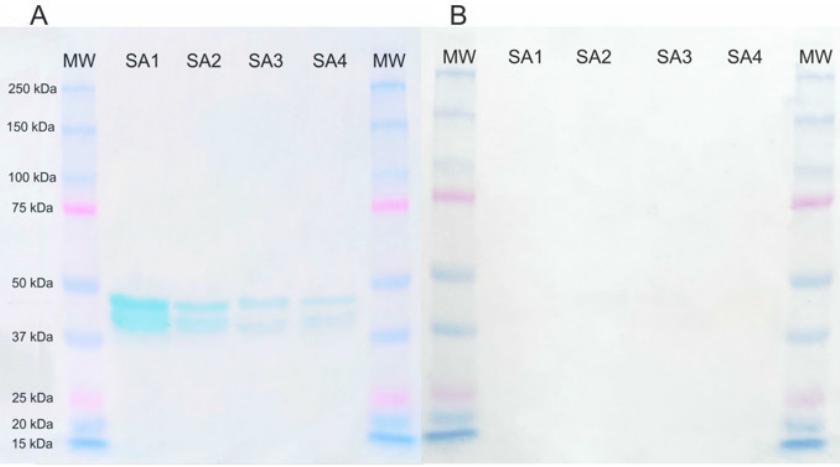
Figure 3. Results of immunodetection of the FnBPA protein fragment in the presence of monoclonal anti-FnBPA antibodies ( A ) and example result of the negative control in the presence of the bovine milk of a healthy cow ( B ). Legend: MW—molecular mass marker (BIO-RAD); SA1–SA4—protein lysates of bovine S. aureus